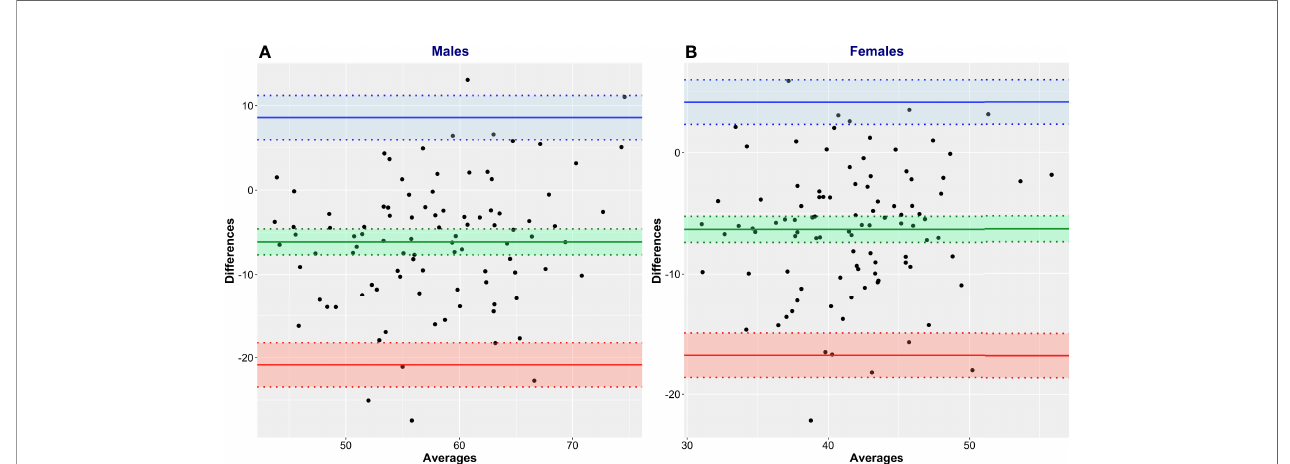
FIGURE 5 | Bland and Altman plots of CT-de fi ned lean body mass (LBM CT ) vs. that estimated by James ’ equation (LBM James ). LBM CT is the reference method, and LBM James is the test method. Men (A) and women (B) .